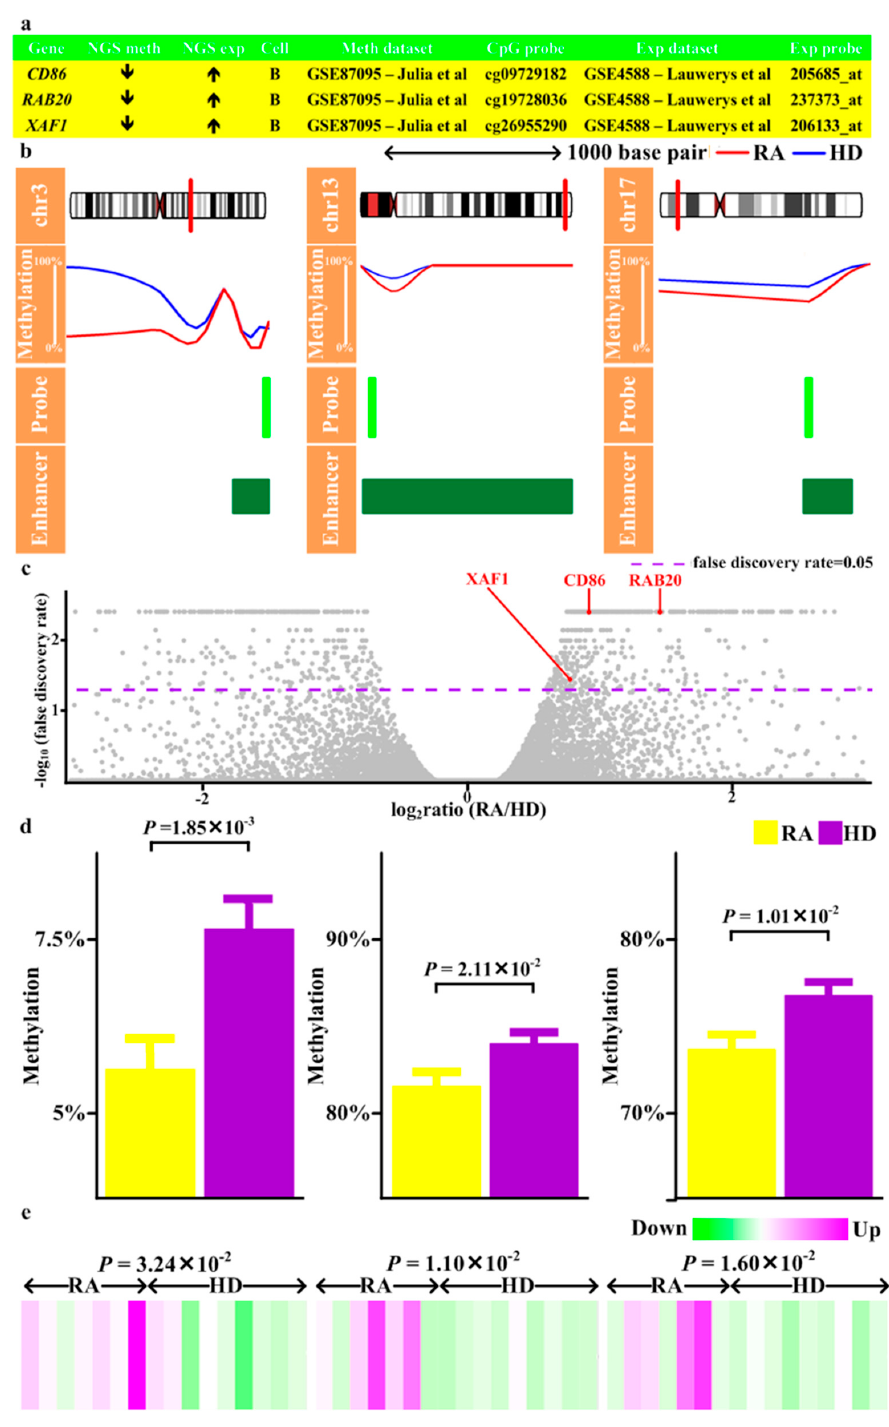
Figure 4. Validation of genes with differential methylation in enhancer and differential expression. ( a ) The results of methylation and expression obtained from next-generation sequencing (NGS meth, NGS exp), the cell subsets of validation dataset (Cell), the dataset of validation (Meth dataset, Exp dataset), and the probes of validation dataset (CpG probe, Exp probe). ( b ) Visualization of the methylation levels obtained from NGS in rheumatoid arthritis (RA) and healthy donors (HD) and location of validated CpG probe and enhancers. ( c ) Volcano plot of the − log 10 (false discovery rate) on the Y-axis versus expression change (log 2 ratio) on the X-axis. Of validated genes, ( d ) Methylation and ( e ) Expression levels of corresponding probes in the validation dataset.